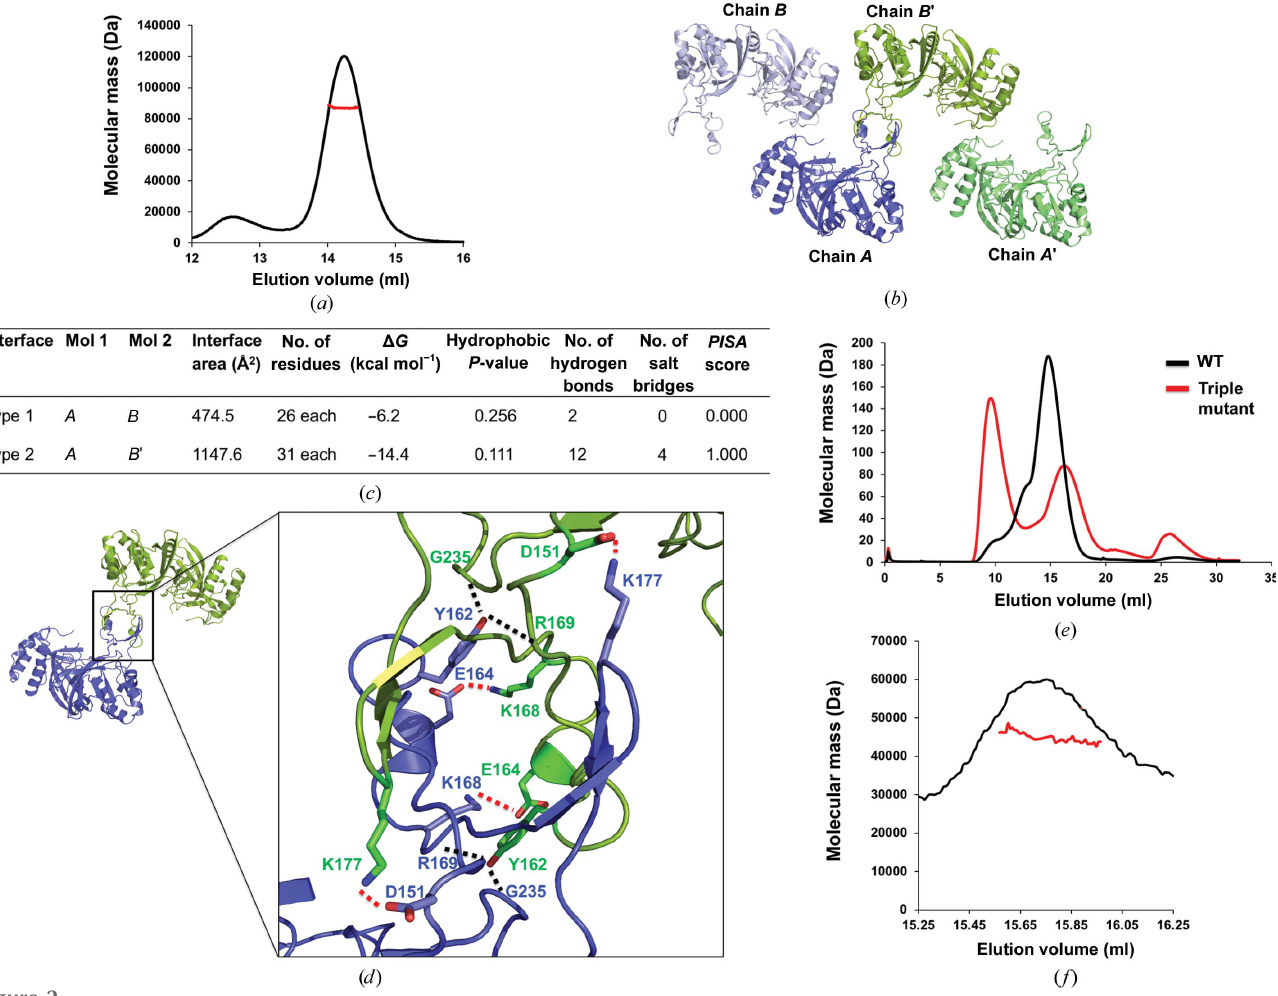
Figure 2 Dimeric structure of abMltA. ( a ) Multi-angle light-scattering (MALS) profile derived from the main size-exclusion chromatography (SEC) peak. The red line indicates the experimental molecular mass analyzed by MALS. ( b ) Crystallographic packing symmetry analysis. The two abMltA molecules found in the asymmetric unit are indicated by blue and light blue ribbon structures, while the other symmetric molecules are indicated by dark green and green ribbon structures. ( c ) Table summarizing the interaction details of the two types of interface analyzed by the PISA server. ( d ) Tentative dimeric structure of abMltA generated and analyzed by symmetry analysis and the PISA server. A magnified view of the region in the black box is provided to the right of the dimeric cartoon figure. Red and black dashed lines indicate salt bridges and hydrogen bonds, respectively. ( e ) Verification of the interfaces via mutagenesis. SEC profiles comparing the positions of eluted peaks between wild-type and mutant protein containing three mutated residues (Asp151 to Lys, Tyr162 to Trp and Glu164 to Lys). ( f ) MALS profiles of the triple mutant of abMltA. The red line indicates the experimental molecular mass analyzed by